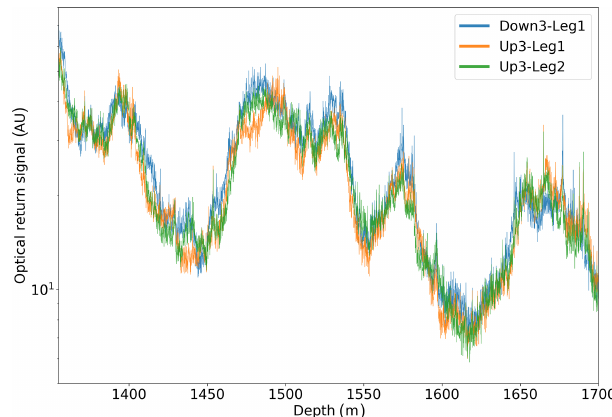
Figure 4. Example detail of optical stratigraphies obtained by log- ging the same depth range three times.